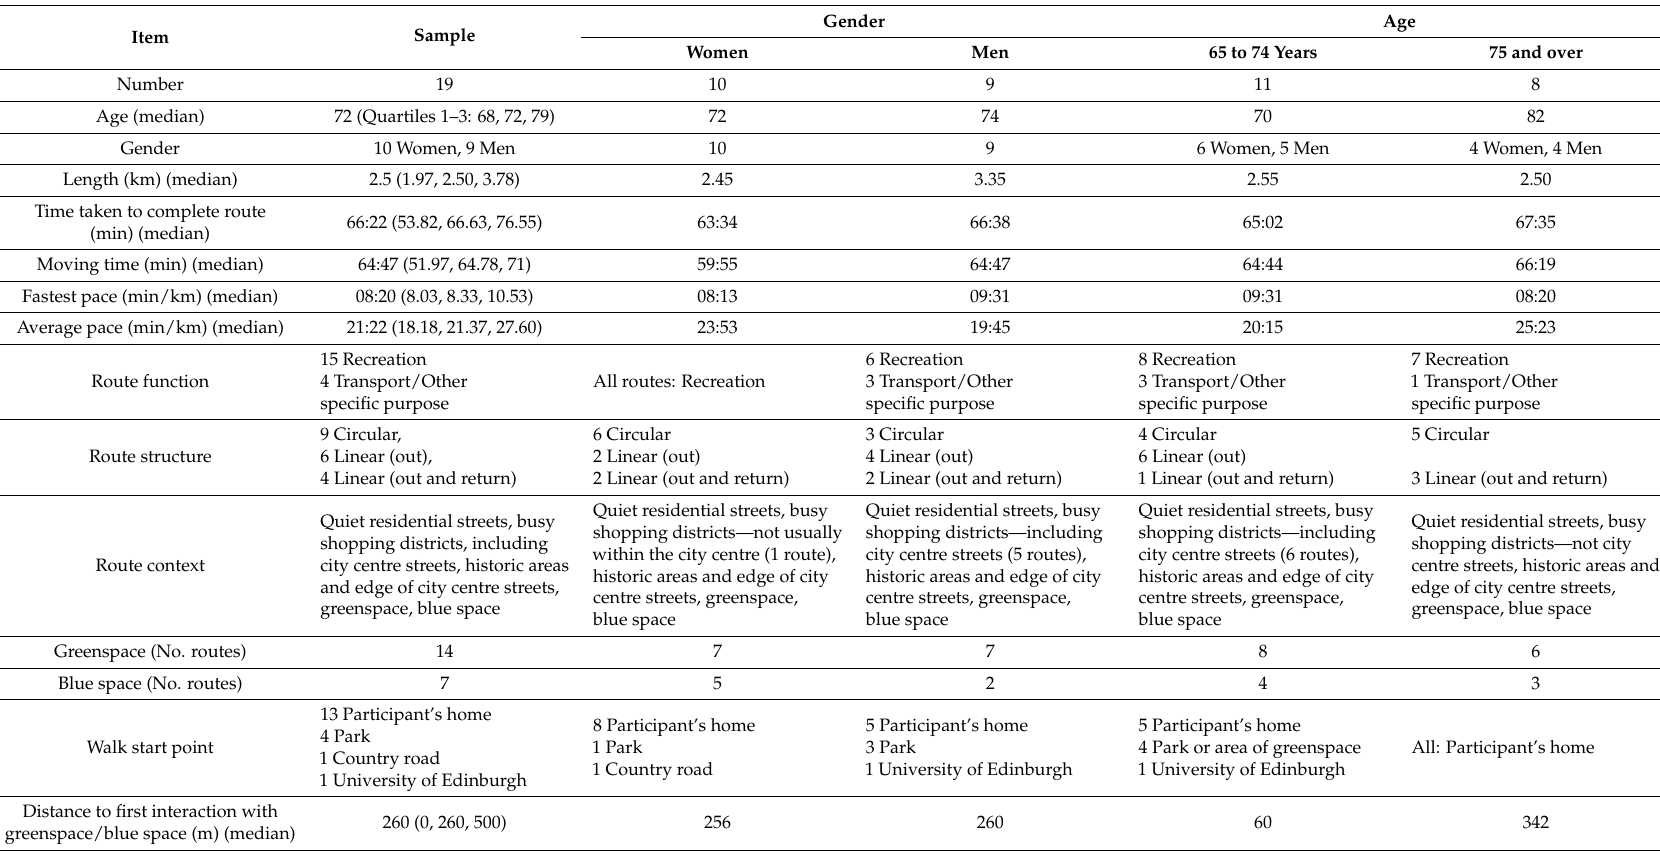
Table 1. Sample and routes by gender and